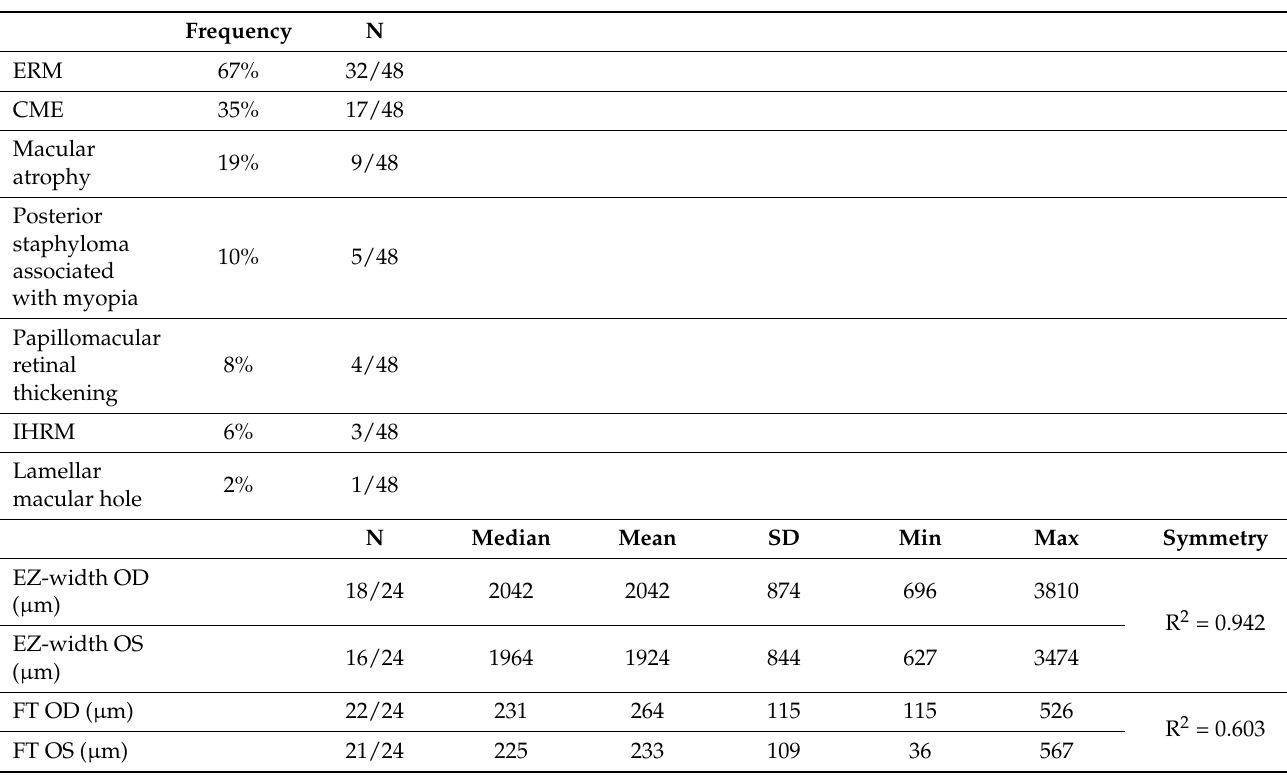
Table 3. Qualitative findings and quantitative measures of optical coherence tomography parameters in PDE6B -associated retinitis pigmentosa